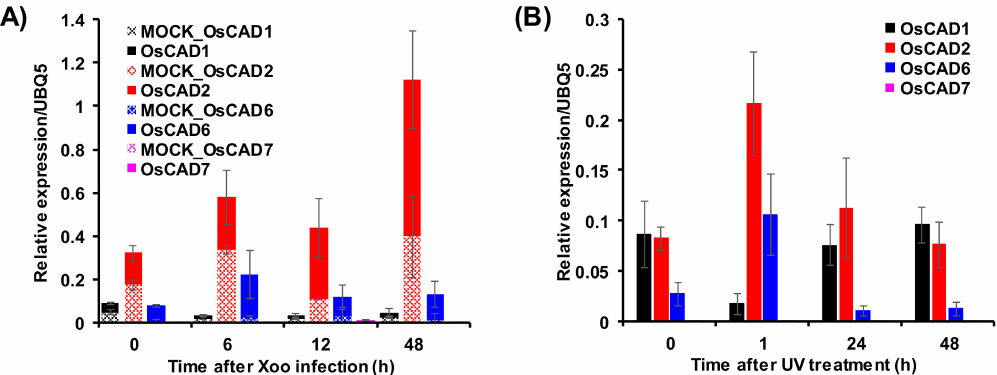
Figure 6. Expression of OsCAD1 , 2 , 6 , and 7 in response to Xoo infection ( A ) and UV-irradiation ( B ). The expression levels of the OsCAD s were examined by qRT-PCR analysis using specific primers (Supplementary Table S2). A ubiquitin gene ( OsUBQ5 ) was amplified and used as an internal control. The expression levels of each OsCAD gene are presented as the relative expression compared to the OsUBQ5 transcript levels. qRT-PCR analysis was performed on triplicate biological